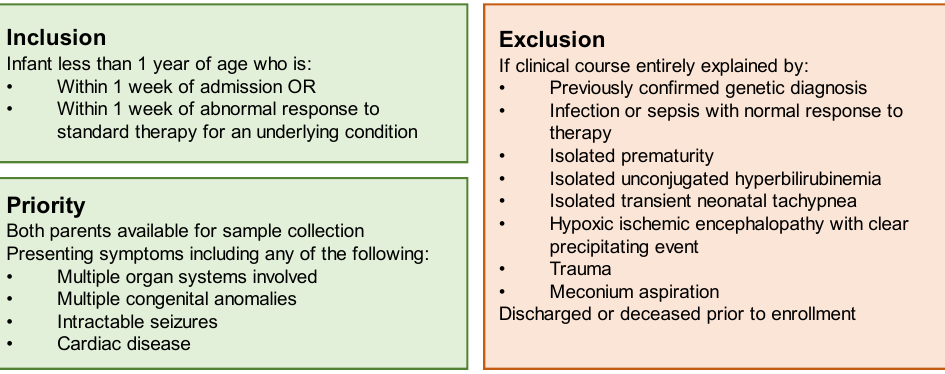
Figure 1. Inclusion and exclusion criteria, utilized specifically by the Duke site, adapted from the overarching Vermont Oxford Rady Children’s Genomic Network study’s inclusion and exclusion criteria.